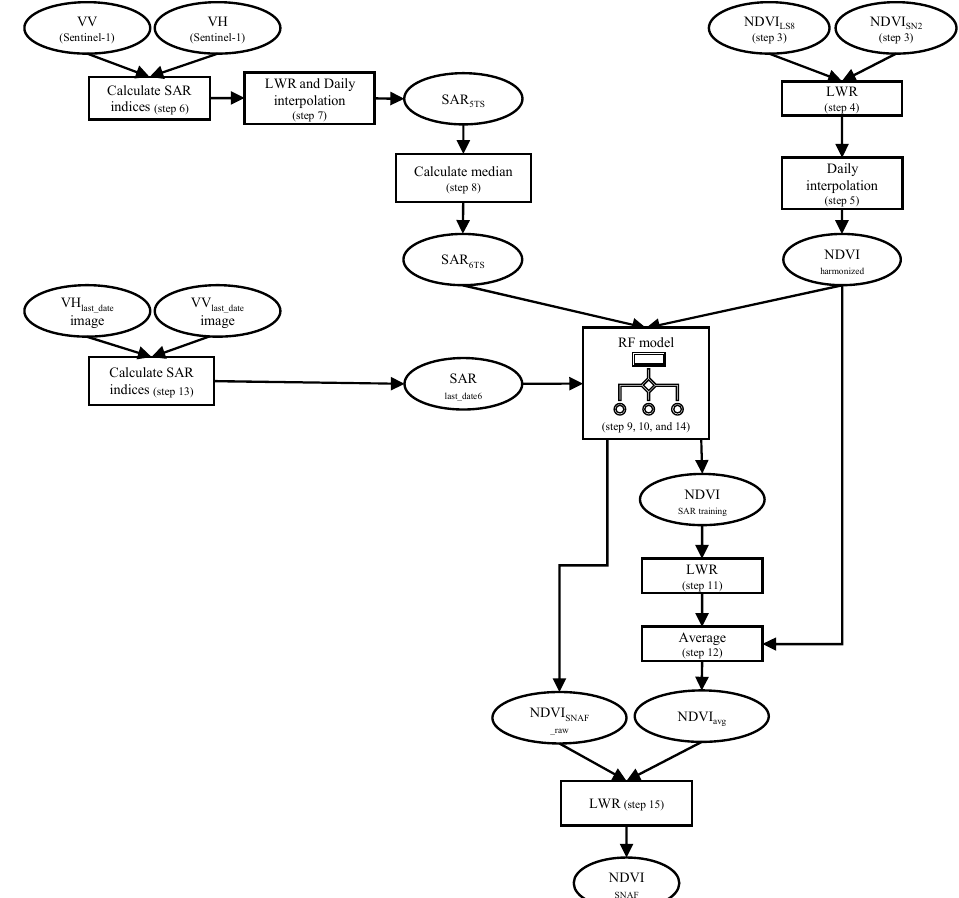
Figure 5. Flowchart of the SNAF method, with the number of the corresponding steps in parentheses.